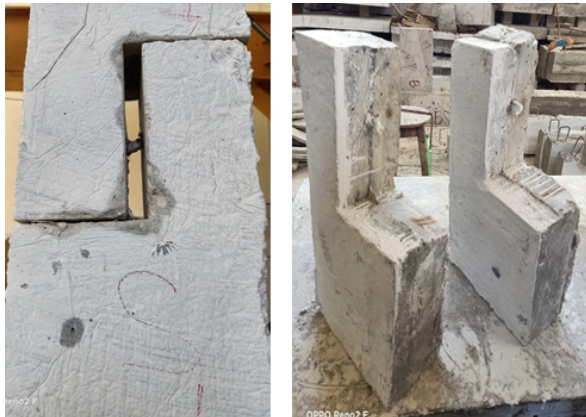
Figure 9: Dowel action samples (failure modes)